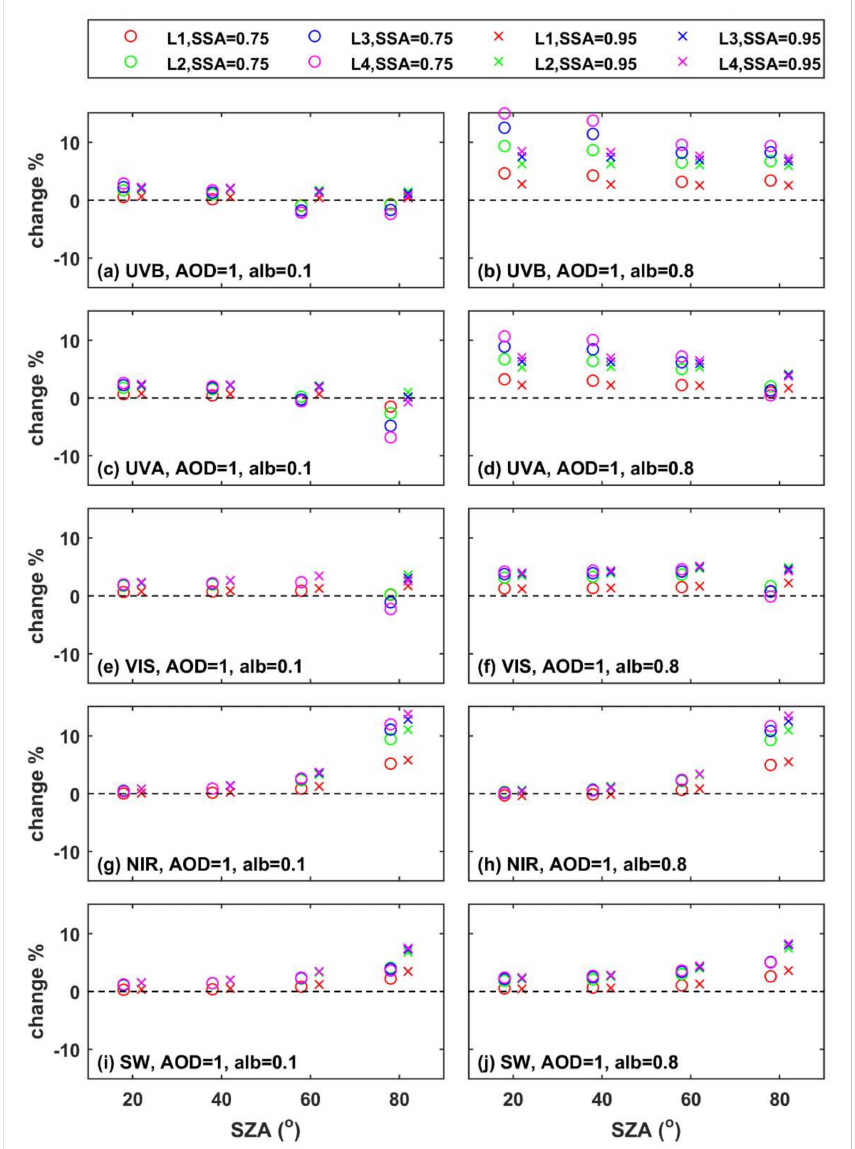
Figure 6. Relative differences in GI at the BOA for different altitudes of the elevated aerosol layer, SSA and surface albedo with respect to the corresponding conditions when aerosols are at L0 (elevated layer—L0). The presented results are for AOD = 1 and TCWV = 1 g/cm 2 . Different rows represent different spectral regions (UVB, UVA, VIS, NIR). Different columns represent different surface albedo (left: 0.1, right: